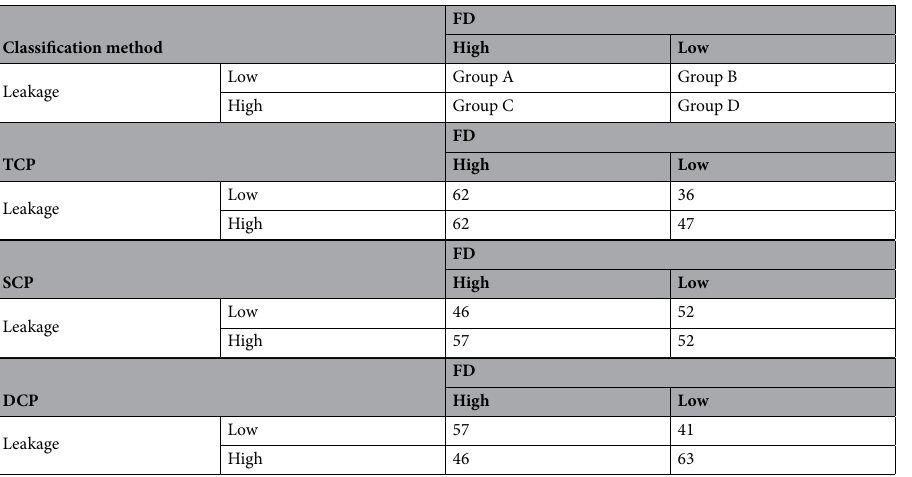
Table 3. Classification of retinal sensitivity measurement points (n = 207) by level of flow density and leakage. FD flow density, TCP total capillary plexus layer, SCP superficial capillary plexus layer, DCP deep capillary plexus layer.